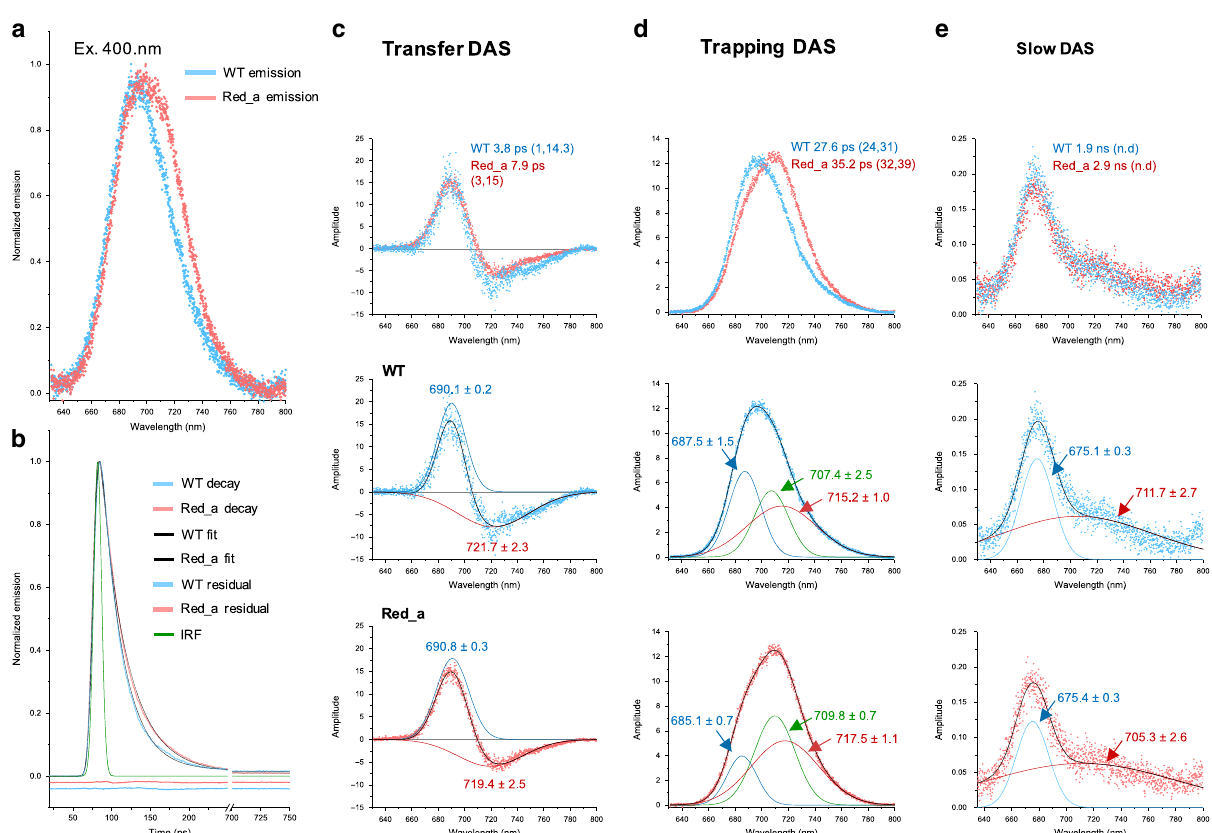
Fig. 5 Trapping kinetics are altered in Red_a. a Normalized emission spectra captured by the streak camera summed over the duration of the experimental time window. b Normalized decay kinetics summed over 640 – 800 nm range for WT (blue circles) and Red_a (red circles), IRF (modeled using a Gaussian, fwhm of ~11 ps) is shown in green together with the fi t (in black) and residuals for both datasets (shifted by − 0.025 and − 0.05, for Red_a and WT respectively). Top frames of c – e show DAS obtained from global analysis using three decay components. The lifetimes associated with each curve are indicated together with con fi dence intervals (calculated as a 1% change in χ 2 value of the fi t at the indicated parameter value with other parameters treated as free). Middle frames c – e show DAS and their Gaussian decomposition for WT PSI. The center wavelengths in nm (±95% con fi dence intervals) are shown for each component. Bottom frames of c – e show DAS and their Gaussian decomposition for Red_a mutant. The center wavelength (±95% con fi dence intervals) are shown for each